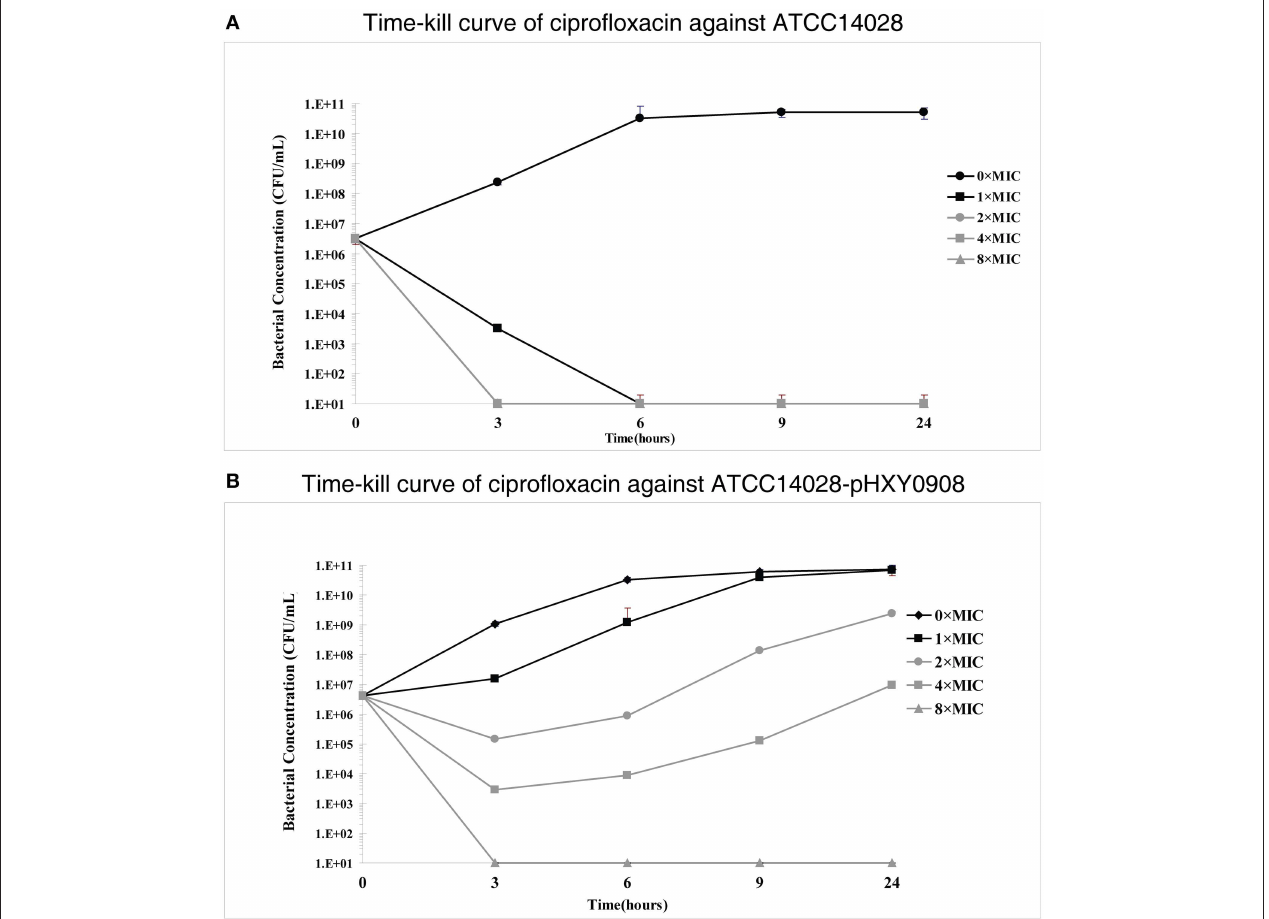
FIGURE 1 | In vitro time-kill studies of ciprofloxacin (A) Salmonella Typhimurium ATCC14028 and (B) and ATCC14028-pHXY0908 1 × MIC is equivalent to 0.03125 mg/L for ATCC14028 and 0.125 mg/L for ATCC14028-pHXY0908. The lines and markers of 2 × MIC and 8 × MIC coincided with 4 × MIC in (A)